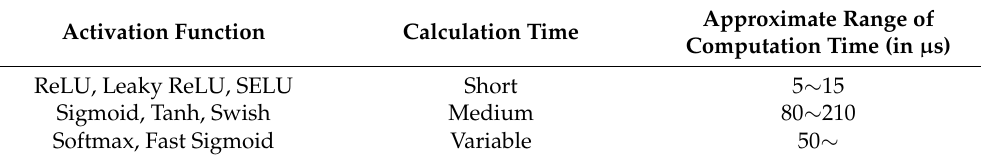
Table 1. Classification of Similar Activation Functions Using Calculation